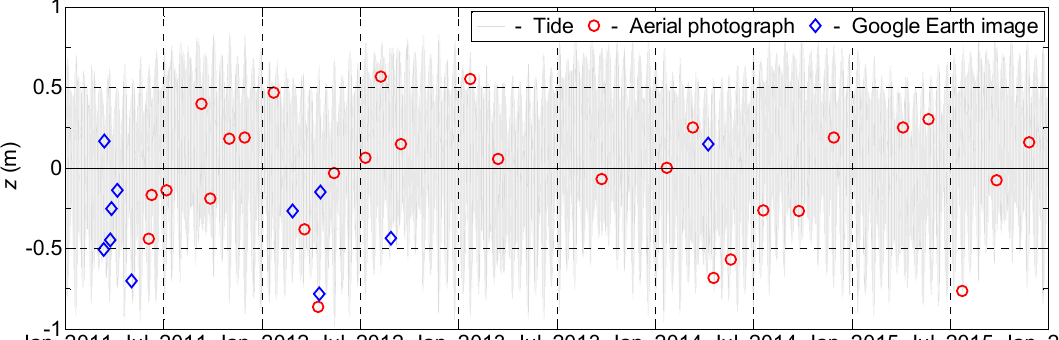
Figure 6. Estimated capture time of image and calculated tidal level at Sendai Port (T.P., Tokyo Peil).